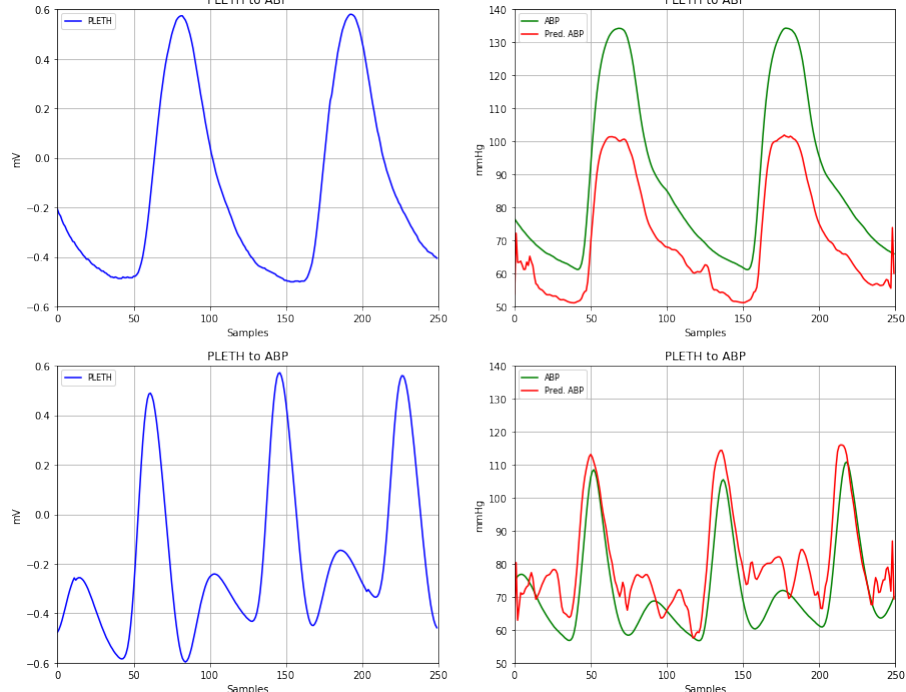
Figure 3. Two records (one in each row) with input signal (PLETH) on the left, and output signal (predicted ABP) and ground true signal (ABP) on the right, for the PLETH to ABP